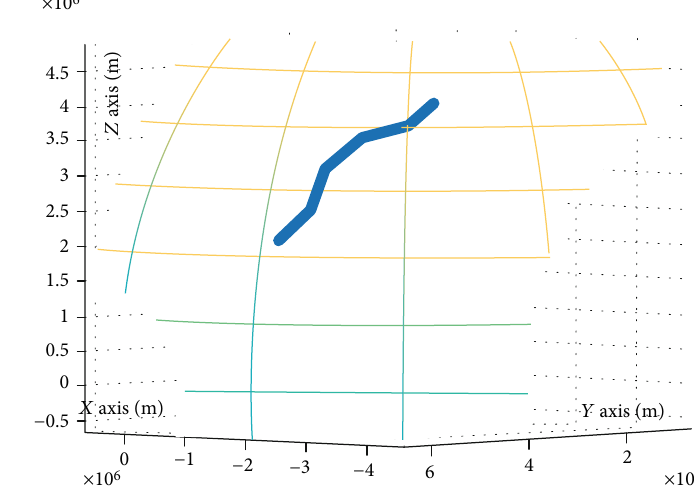
Figure 14: Cruise trace of an aerospace vehicle.